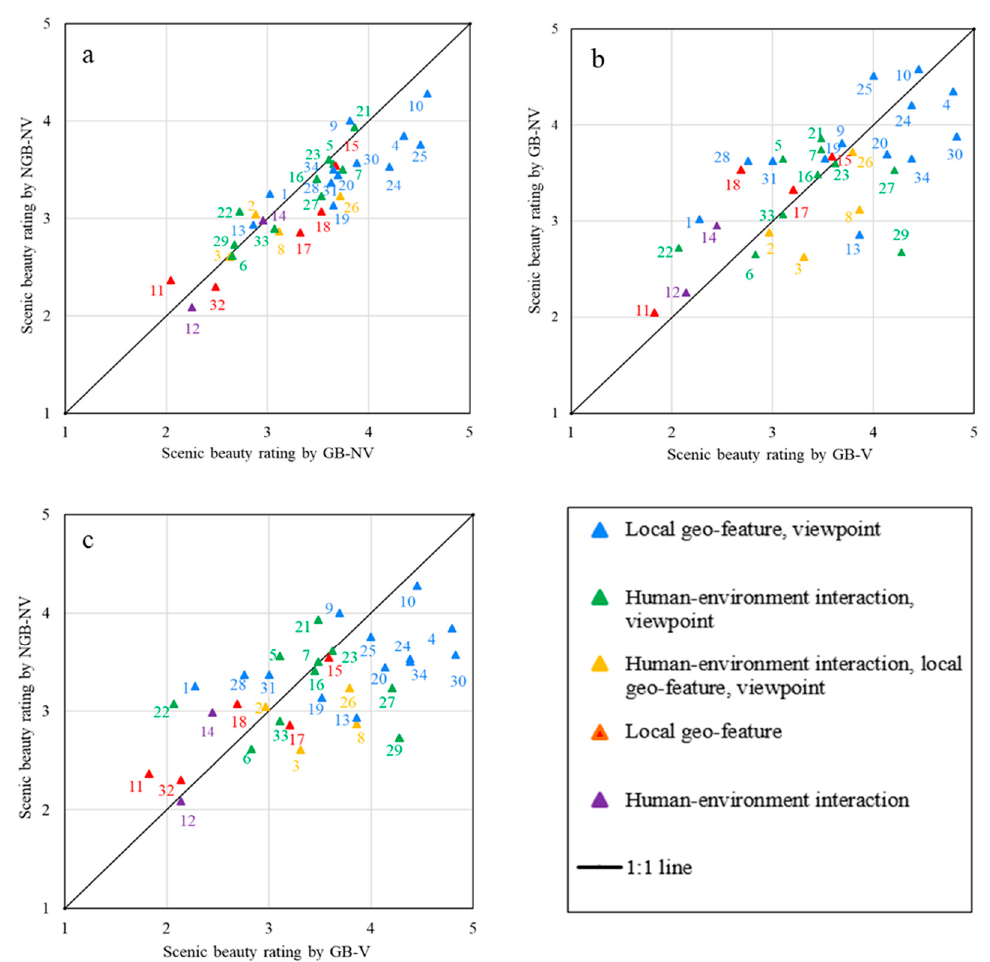
Figure 7. ( a – c ) Comparison of mean scenic beauty ratings of the 34 geosites by the three respondent groups, grouped following their geoscience background and field visits: NGB-NV = no geoscience background and no visit to geosites; GB-NV = geoscience background and no visit to geosites; GB-V = geoscience background and visit to geosites. Scenic beauty was rated on a 1–5 scale. See Figure 1b for the location of geosites (indicated by their number in the figures); Table A1 in Appendix A for their description, Table A4 in Appendix A for their mean scenic beauty rating; Questionnaire S1 in the Supplementary Materials for their photos.